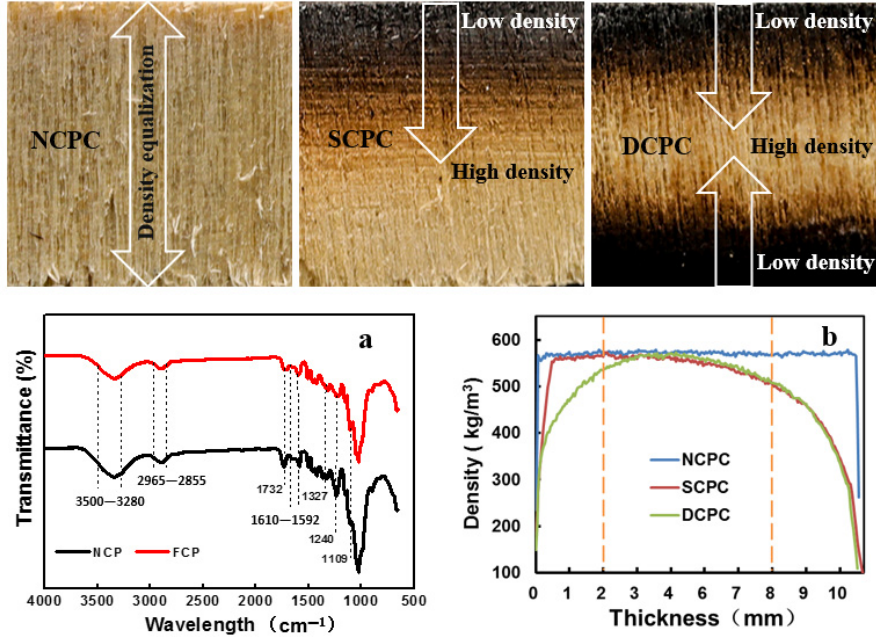
Figure 8. Profile density and composition change analysis. ( a ) FTIR analysis of uncarbonized and fully carbonized poplar; ( b ) sectional density analysis of NCPC, SCPC, and DCPC specimens from the perspective of their thickness (mm).